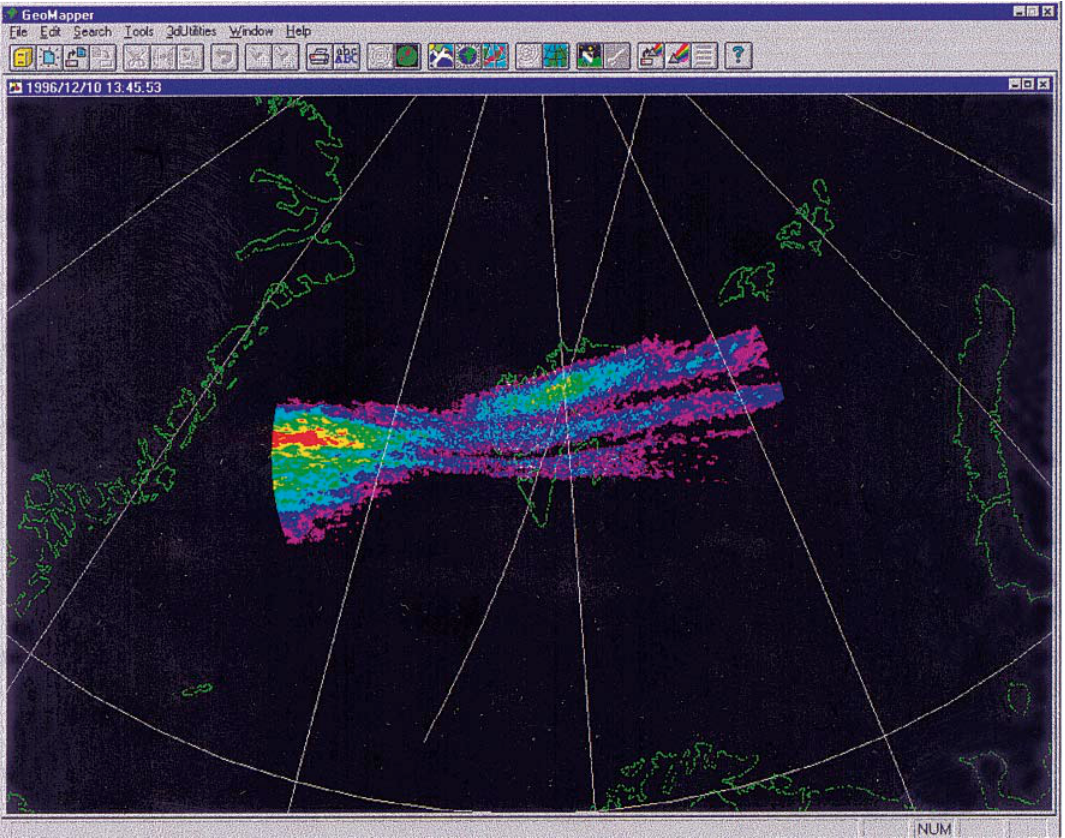
satellite pass crossing 75 (cid:176) N at 13:48 UT is indicated on the figure by the line from northeast to